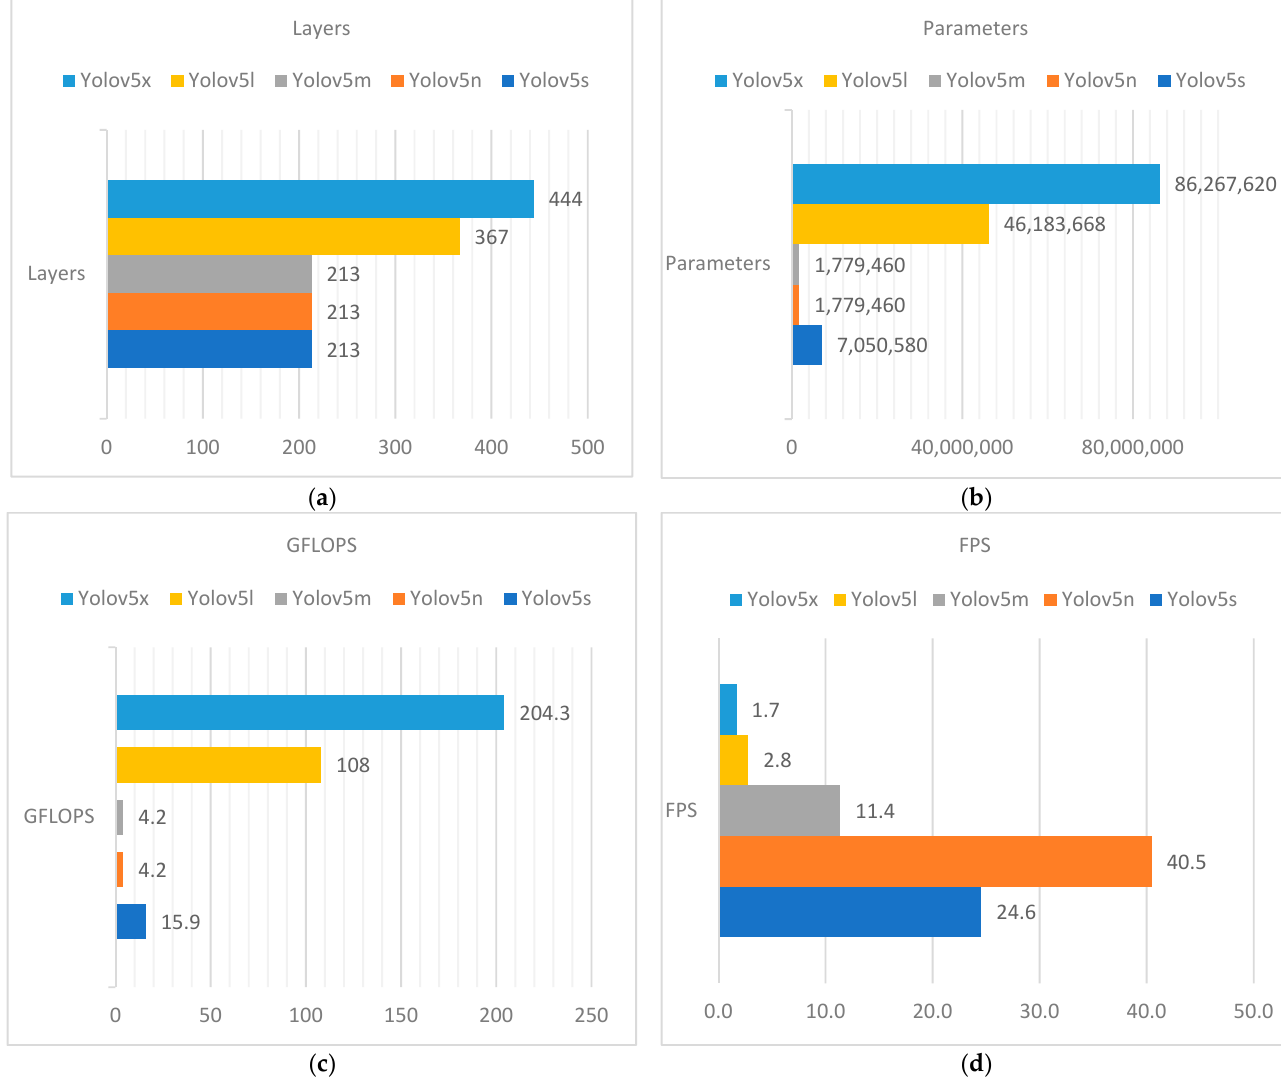
Figure 7. Comparison of the ( a ) Layers, ( b ) parameters, ( c ) GFLOPS, and ( d ) FPS.